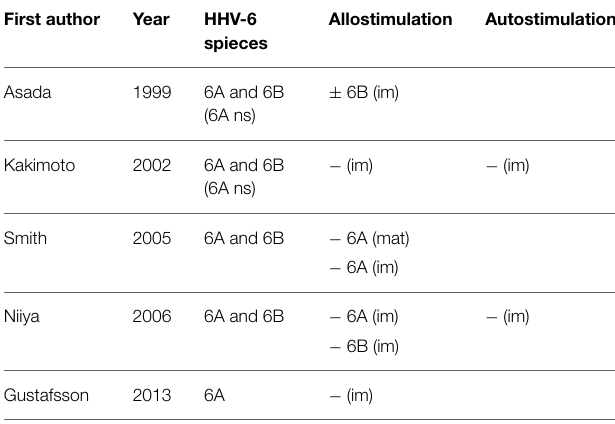
TABLE 3 | Studies on allo- and autoreactivity after HHV-6 exposure of